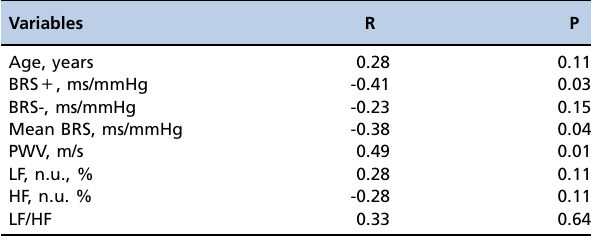
Table 3 - Single linear regression (Pearson) with mean blood pressure serving as the dependent variable. Variables R